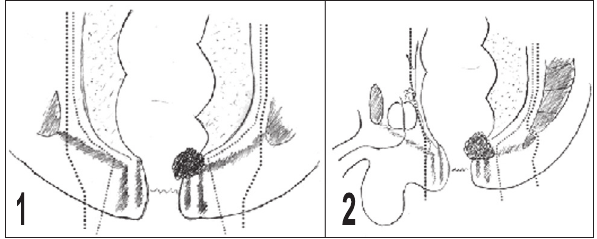
Figure 1 Diagram representation of “standard” (red lines) and cylindrical APER (blue lines), coronal plane. Figure 2. Diagram of “standard” (red lines) and cylindrical APER (blue lines), sagittal plane.